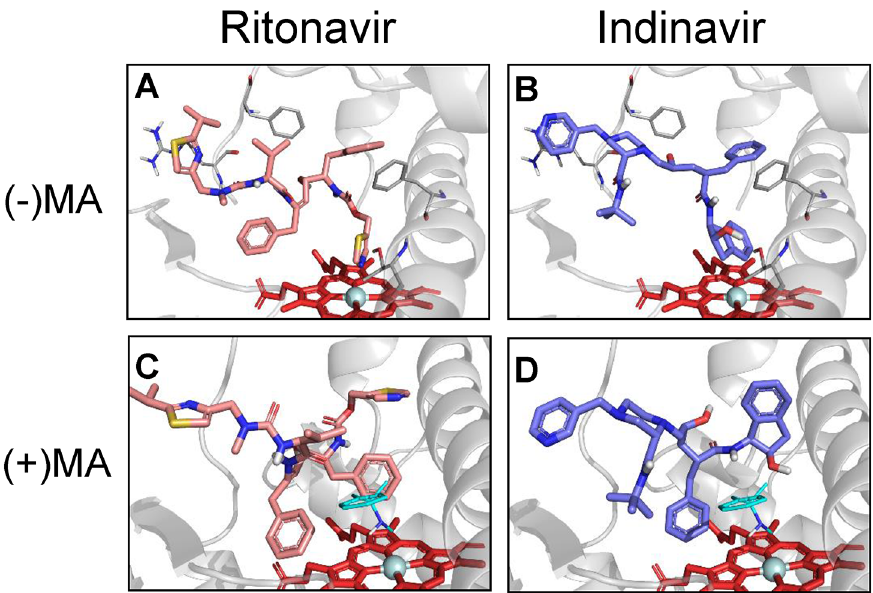
Fig 7. Docking simulations of Type II PIs in the absence and presence of methamphetamine. Structures of (A) Ritonavir and (B) Indinavir with their preferred binding sites pointing towards the heme moiety of CYP3A4in the absence of methamphetamine. Docking simulations of (C) Ritonavir and (D) Indinavir with heme moiety of CYP3A4 in the presence of methamphetamine. R-methamphetamine in binding mode 1 was shown in cyan sticks. Docking was performed as described in Materials and